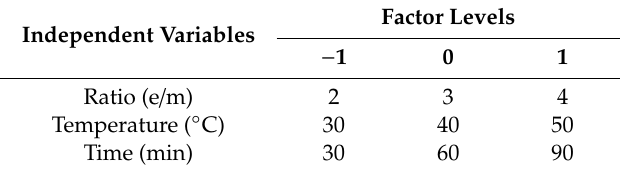
Table 7. Independent variables and the factor levels of the